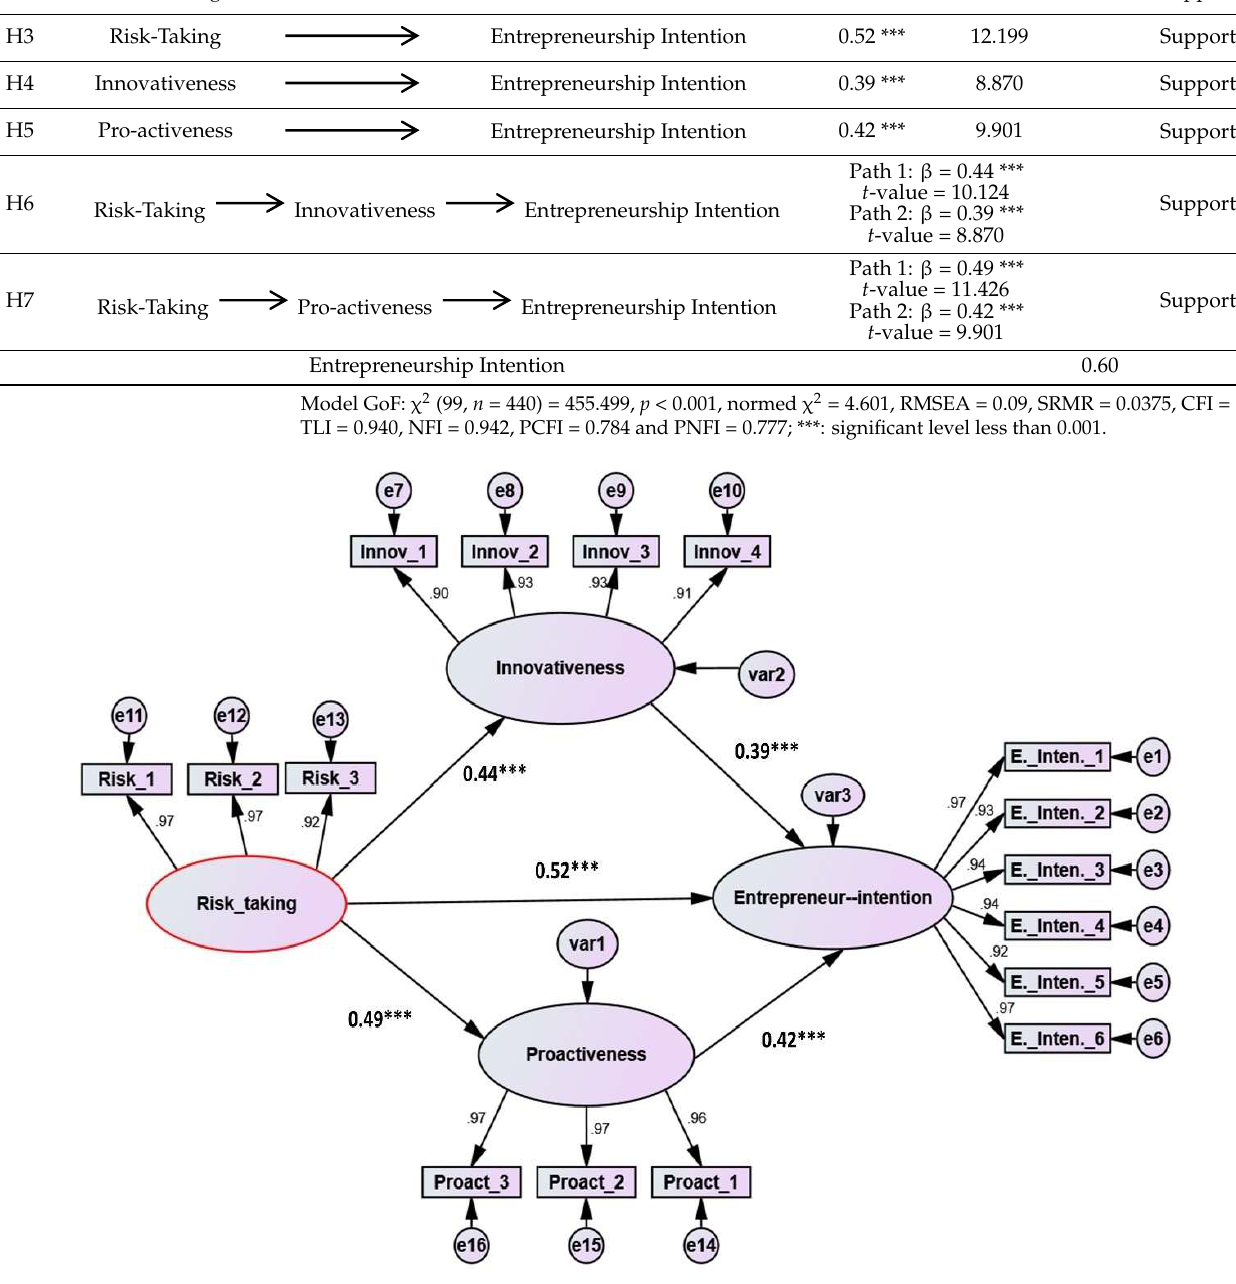
Figure 3. The Study Model. Note: ***: significant level below 0.001. Table 3. The structural model’s results.